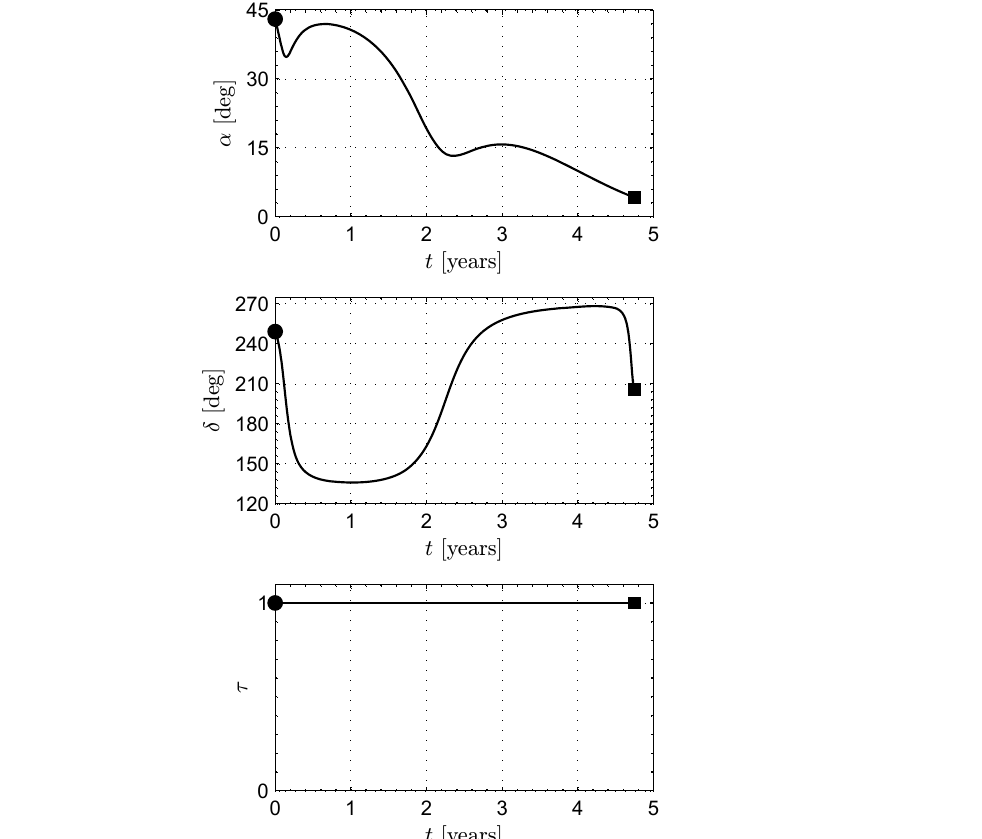
Figure 12. Tie variation of the control variables { τ , α , δ } when r HP = 2.5au. Black circle → start, and black square → arrival/equilibrium